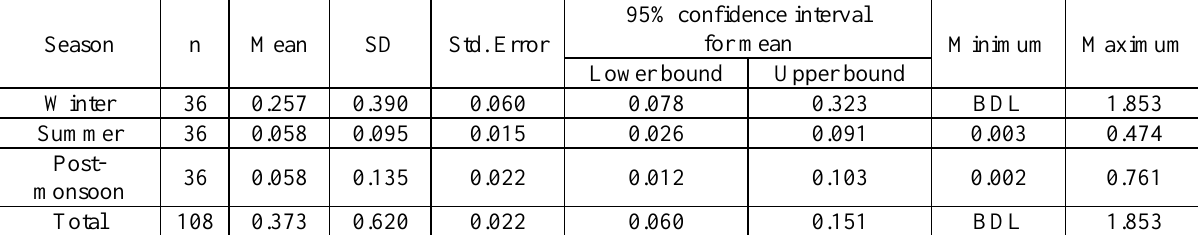
Table 11. Descriptive details for one way ANOVA for groundwater manganese